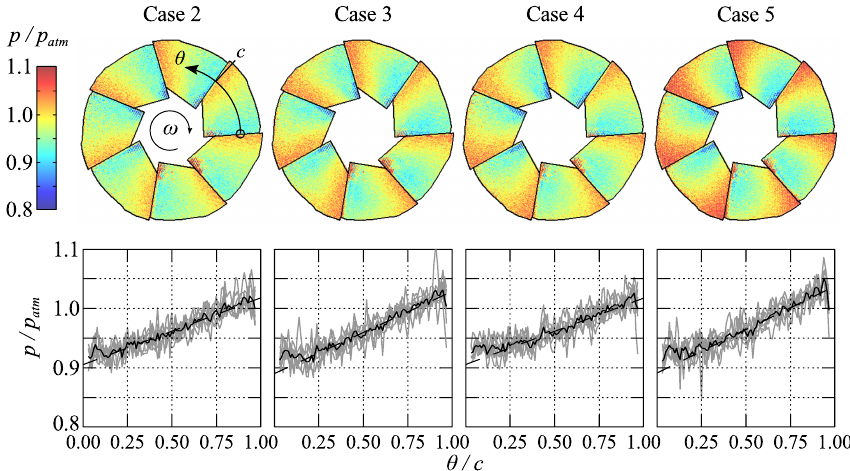
Figure 12. Pressure distribution on the impeller blades (upper row of figure) from scanning measurements for cases 2, 3, 4 and 5, i.e. , with decreasing flow rate at a constant rotational speed. The lower row of the figure shows the pressure along the chord, defined in case 2 as c = 2 π /7, of the blade at half the blade radius, grey lines show the distribution from the seven individual blades, black line their